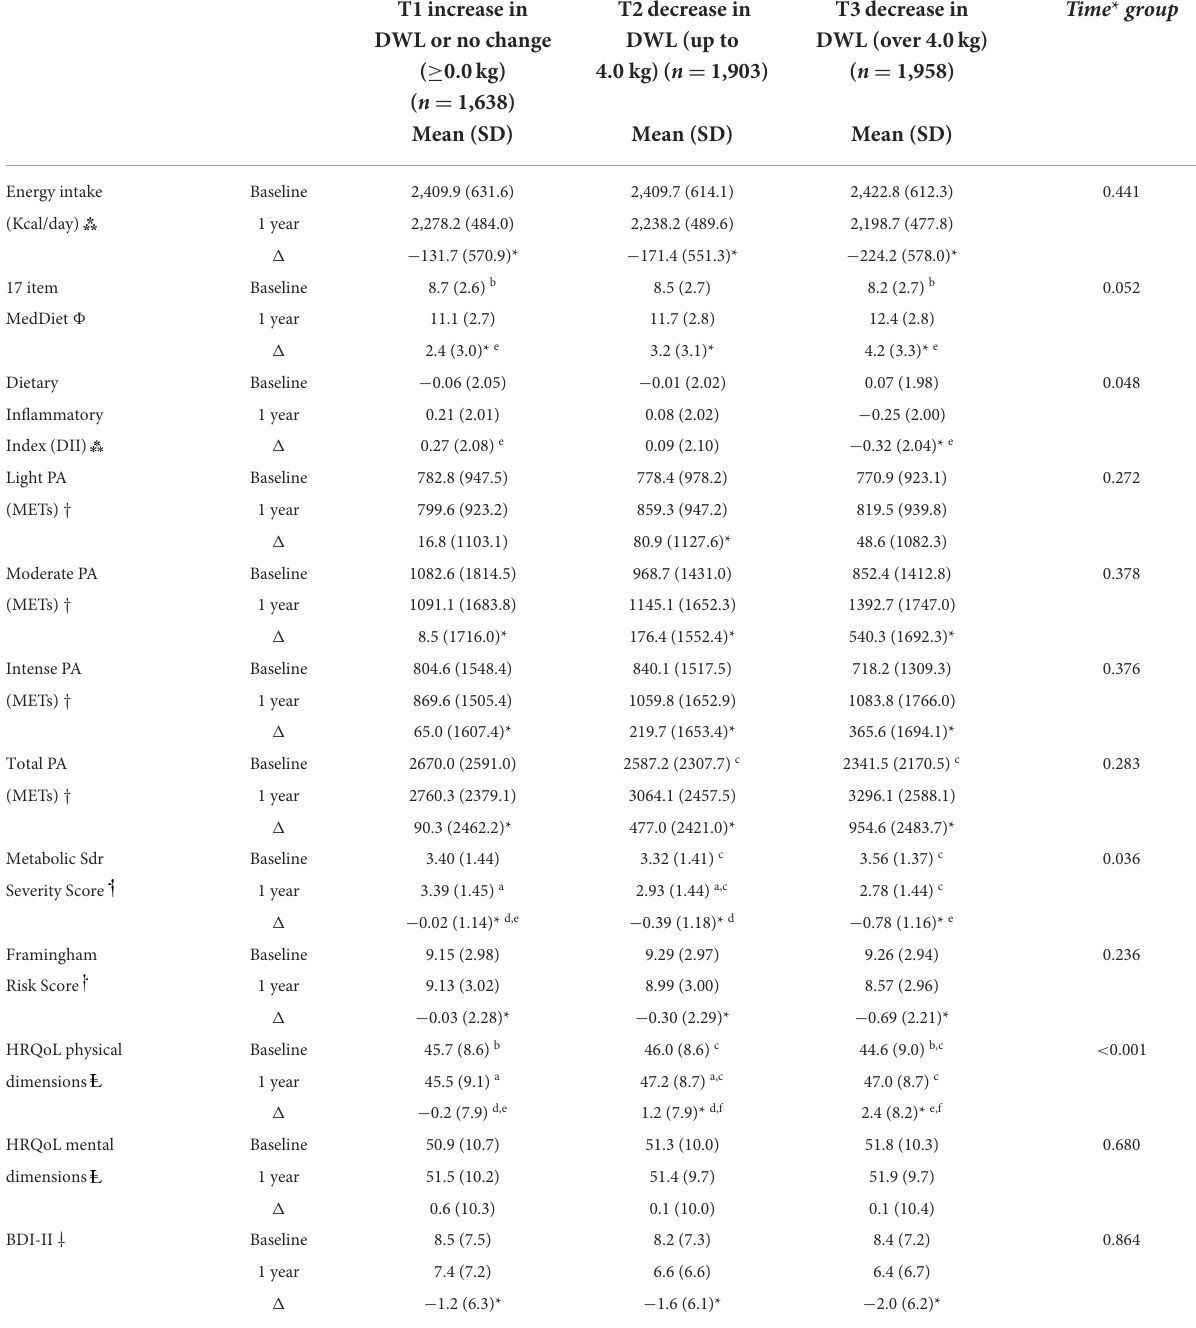
TABLE 3 Health behaviors, perceptions and indexes according to tertiles of change of